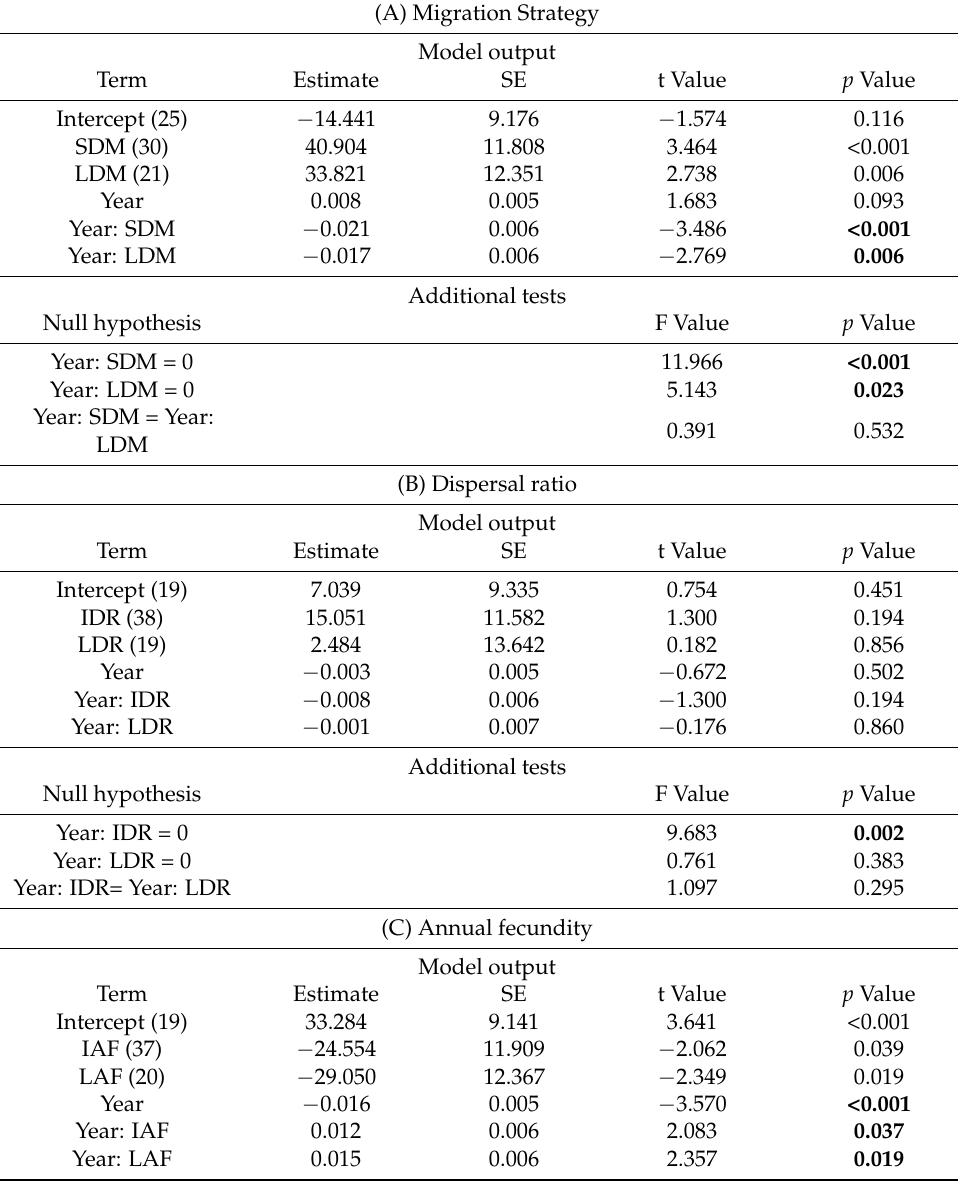
Table 2. Weighted linear regression models showing the response of avian functional groups in relation to life-history traits. In “model output” are shown model statistics (estimate, estimated coefficient; SE, standard error; t value, t-statistic) and the significance of each coefficient ( p value). The term “Intercept” and “Year” represent the reference group. The number of species included in each group is shown in parentheses. In “Additional tests” are shown tests of equivalence to zero of interaction effect of non-reference levels and tests of equivalence between the interaction terms for the other levels (F value: F statistic). Significant p values ( ≤ 0.05) for the interaction terms are marked in bold (A) Migration strategy. Groups: sedentary (reference level), short distance migrants (SDM), long distance migrants (LDM); adj-R 2 = 0.05. (B) Dispersal ratio: Groups: high dispersal ratio (reference level), intermediate dispersal ratio (IDR), limited dispersal ratio (LDR); adj-R 2 = 0.01. (C)